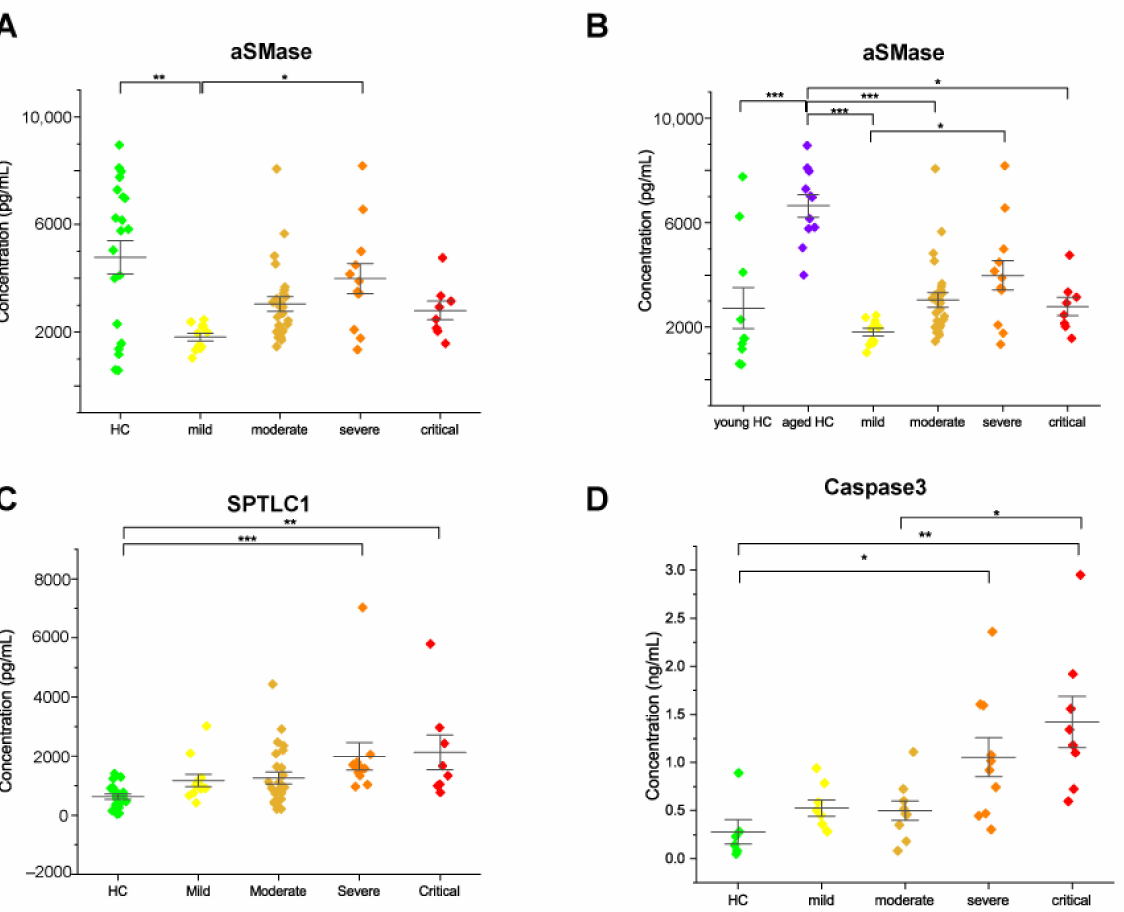
Figure 7. Scatter interval plots of acid SMase ( A , B ), serine palmitoyltransferase subunit 1 (SPTLC1) ( C ) and, caspase 3 ( D ) in serum of HC subjects, mild, moderate, severe, and critical patients, detected by ELISA assay. Each measurement was performed in duplicate. Data were analyzed using Kruskal-Wallis ANOVA, followed by Dunn’s post hoc test for multiple comparisons. * p -value < 0.05, ** p -value < 0.01, *** p -value <